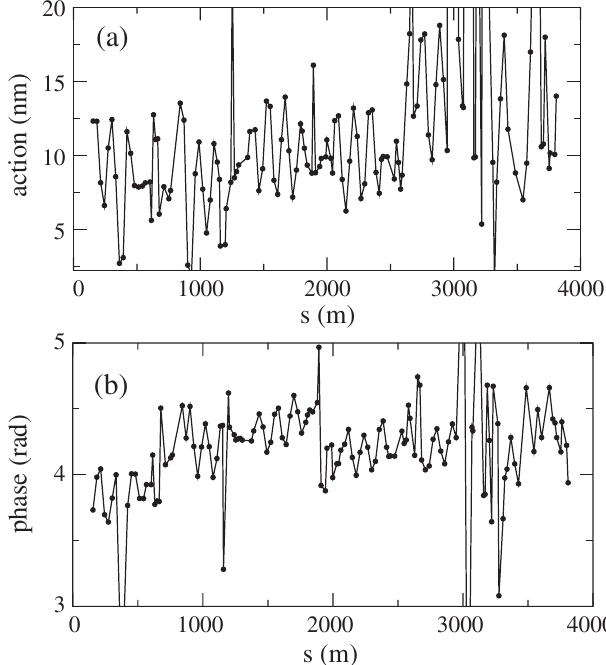
FIG. 12. Action and phase analysis of a RHIC difference orbit taken during the 2002 proton run. The difference is built out of two separated first turn orbits named bi8-qs3.-0.0010.8h.sdds and